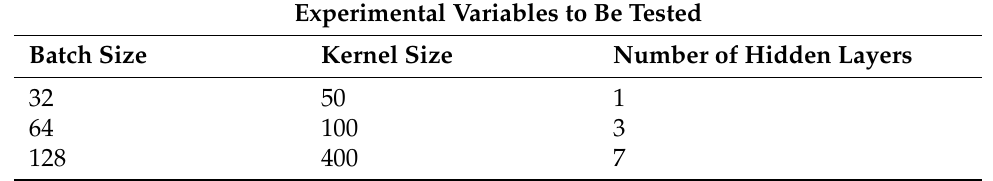
Table 1. Initial parameters of the